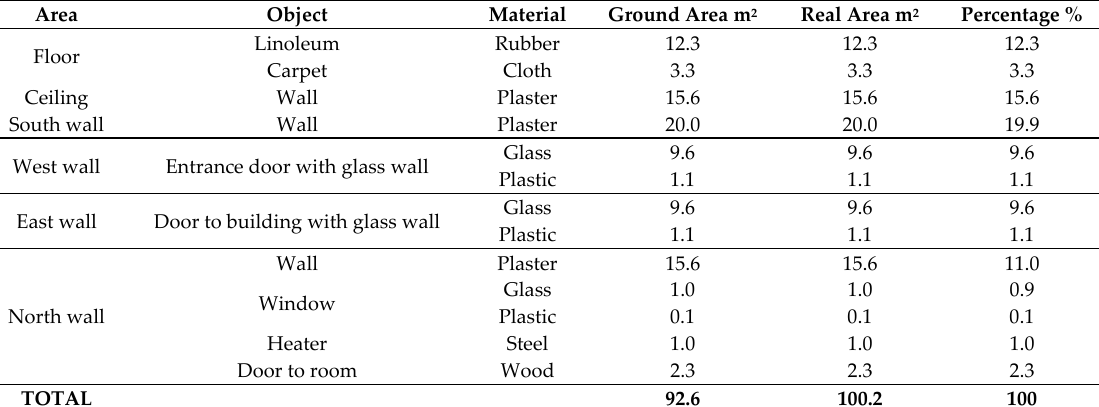
Table 2. List of materials in